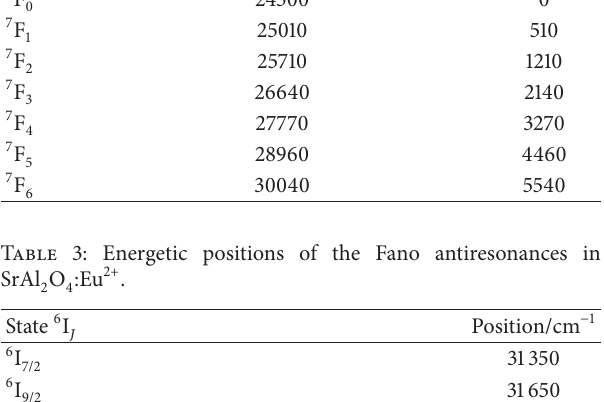
= 27 624 cm −1 ) and (c) ex